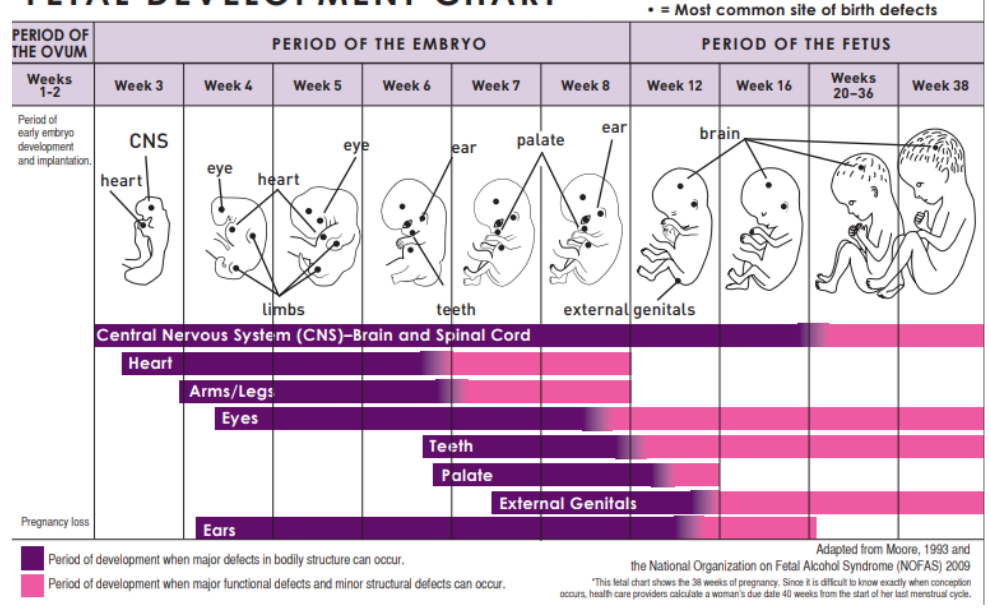
Figure 1. Fetal development